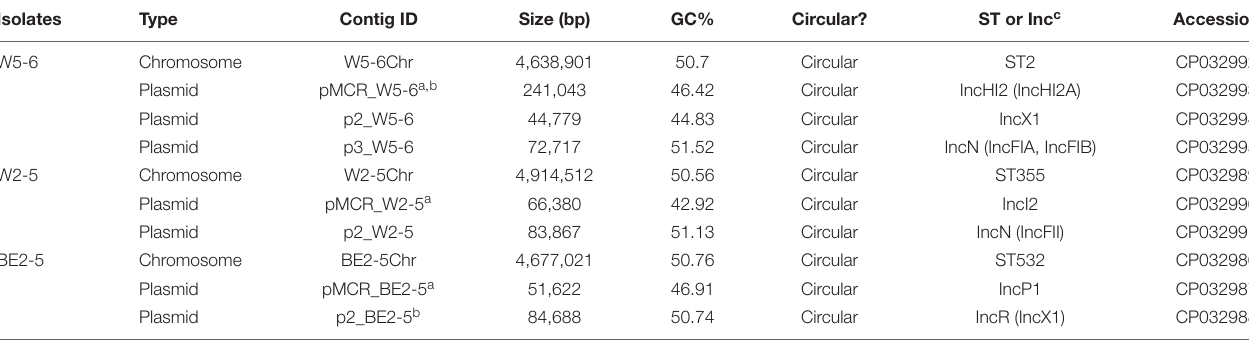
TABLE 1 | Genome assembly results for three E. coli